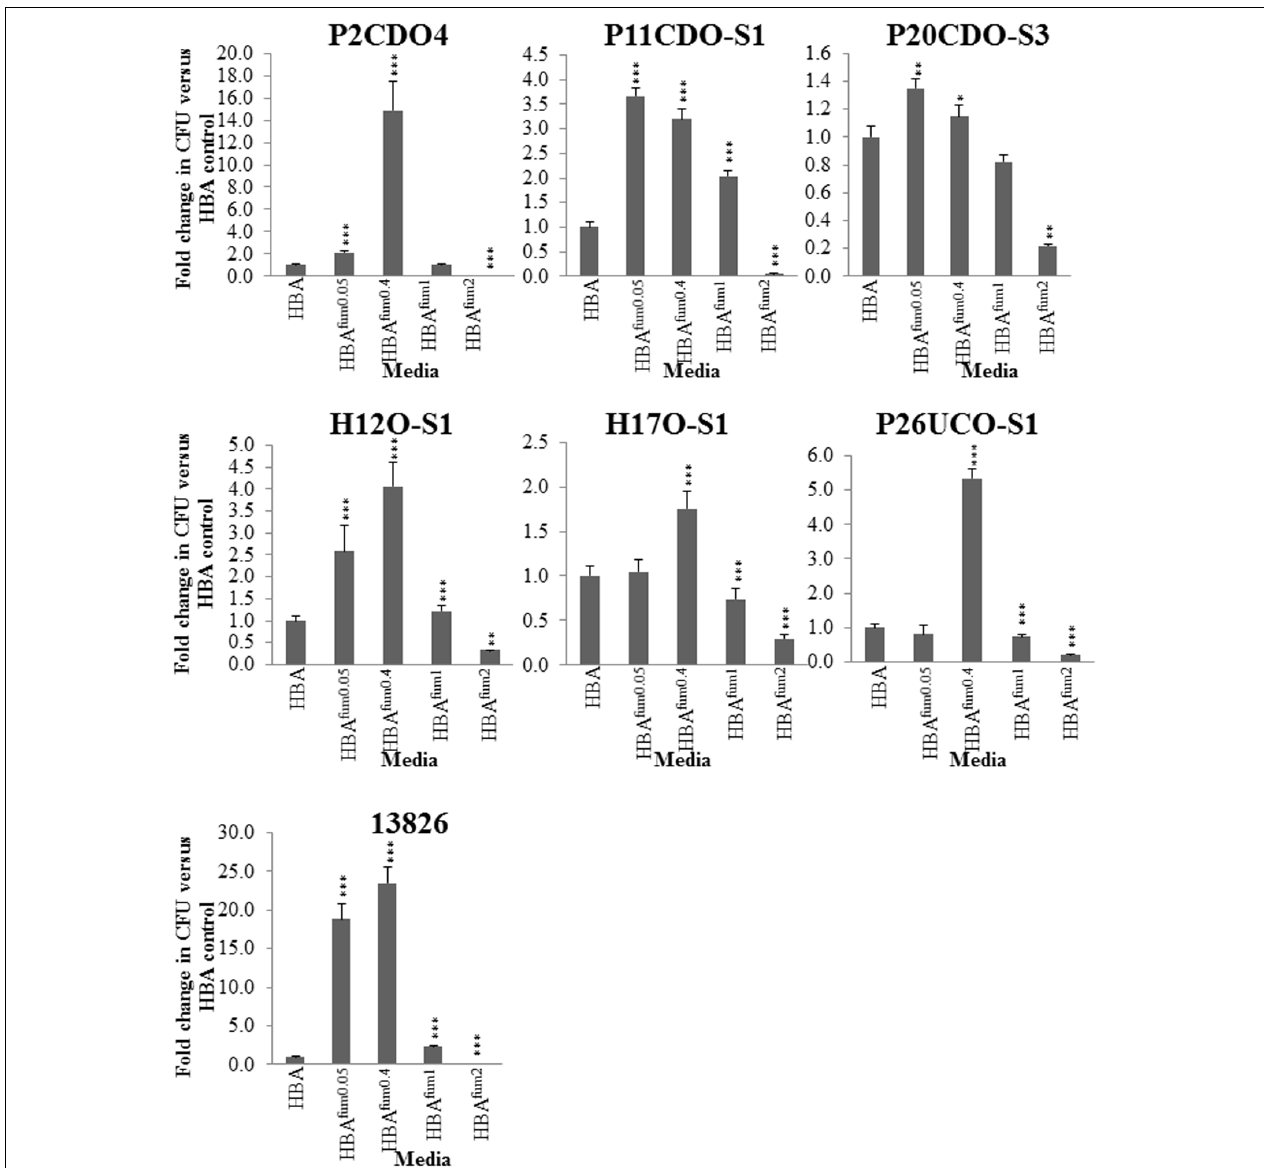
FIGURE 4 | Quantitative analysis of C. concisus cultured in the presence of varying concentrations of sodium fumarate. Seven randomly chosen strains of C. concisus were grown on HBA plates with varying concentrations of sodium fumarate; the number following Fum indicates the percentage of sodium fumarate in the HBA plate. Each strain was then collected and the CFU were enumerated. Fold changes were calculated relative to the CFU of the same strain cultured on HBA from quadruplicate counts. ∗ indicates p < 0.05, ∗∗ indicates p < 0.01, and ∗∗∗ indicates p <